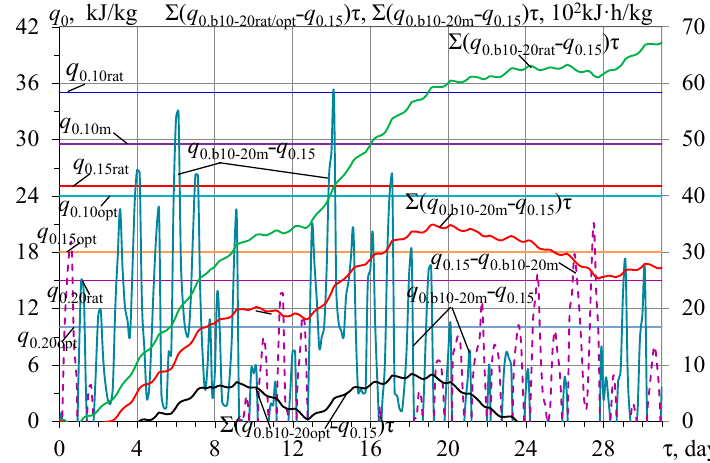
Figure 9. Current values of excess of available middle design cooling capacity q 0.b10-20m − q 0.15 , deficit of middle design cooling capacity q 0.15 − q 0.b10-20m , and summarized excess of available accumulated refrigeration energy according to optimum Σ ( q 0.b10-20opt − q 0.15 ) τ and rational Σ ( q 0.b10-20rat − q 0.15 ) τ designing and middle values Σ ( q 0.b10-20m − q 0.15 ) τ .